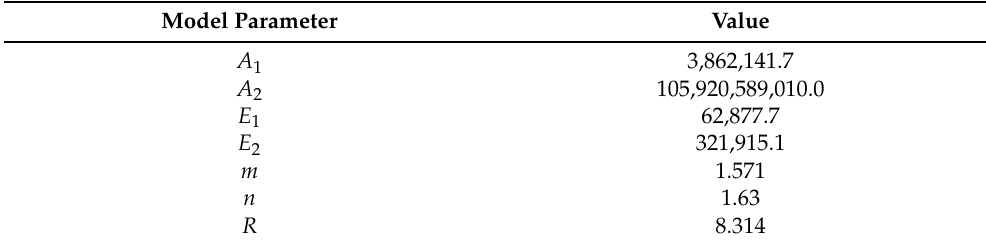
Table 2. Parameter values used for the Kamal–Malkin kinetic model.